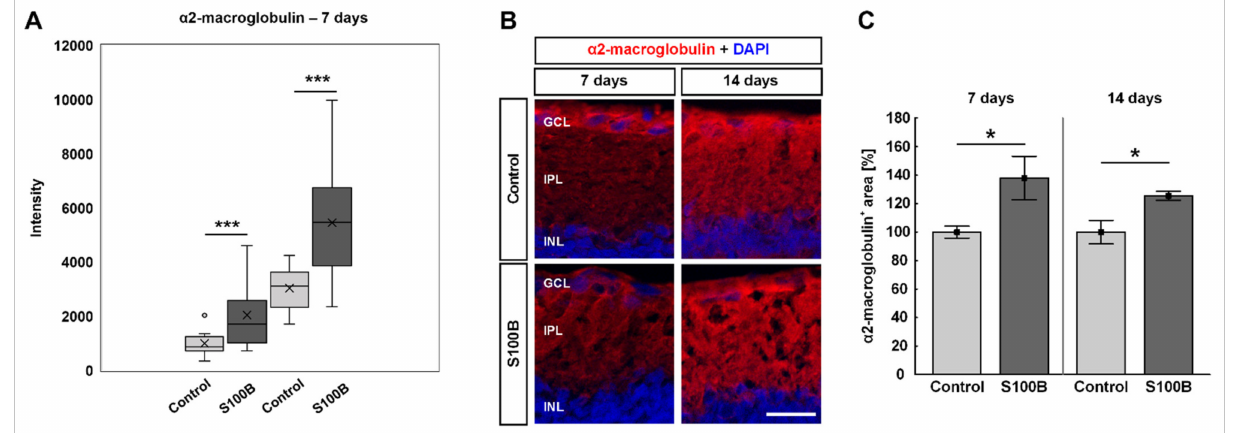
Figure 8. More α 2-macroglobulin expression after immunization. ( A ) At 7 days after S100B immu- nization, the intensities of two peptide sequences of α 2-macroglobulin were significantly